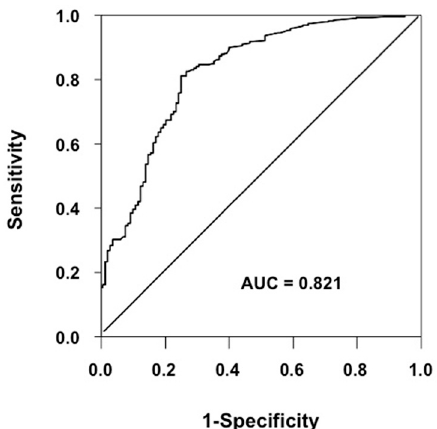
Figure 1. Receiver operating characteristic (ROC) curve for the accuracy of γ -GT for identifying patients with endothelial dysfunction. The accuracy of γ -GT for identifying patients with endothelial dysfunction is 82.1% (AUC = 0.821, p < 0.001).